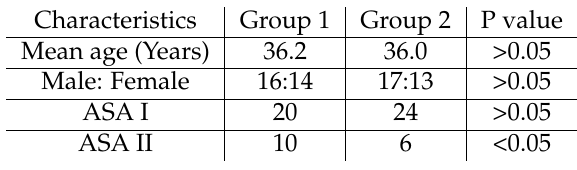
Table 1. Demographic characteristics